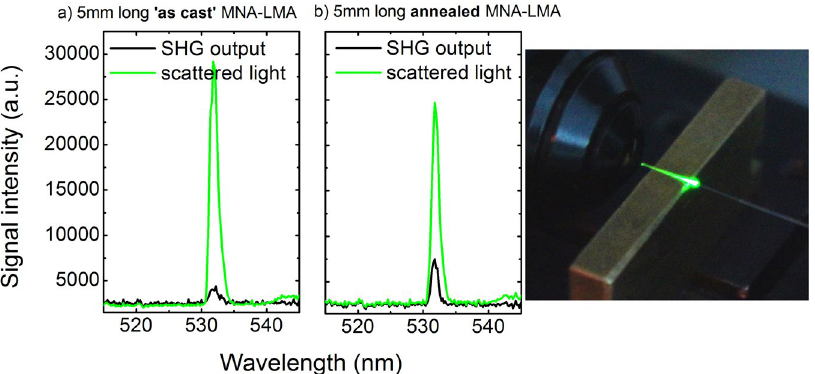
Figure 6. Second harmonic generation modal output (black line) and scattered light (green line) from 5 mm long samples: ( a ) MNA-LMA optical fiber (‘as-produced’) and ( b ) annealed MNA-LMA optical fiber. Right hand side picture: SHG from MNA-LMA